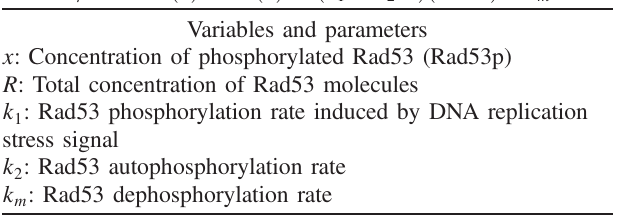
TABLE I. Deterministic model of Rad53 phosphorylation. ODE dynamics